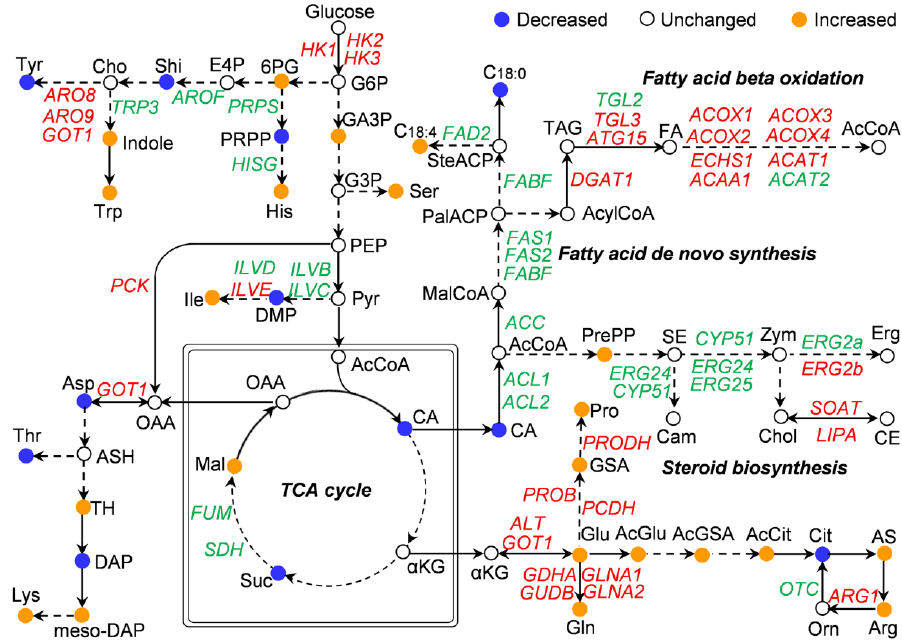
Figure 5. Schematic overview of lipids and amino acid changes in metabolic flux and transcript level. The up-regulated genes and the down-regulated genes were lighted in red and green, respectively. The colored balls (blue, brown, and white) represent different compounds. Abbreviations for enzyme and annotations are shown in Table S8. Abbreviations for metabolites are listed in Table S9.